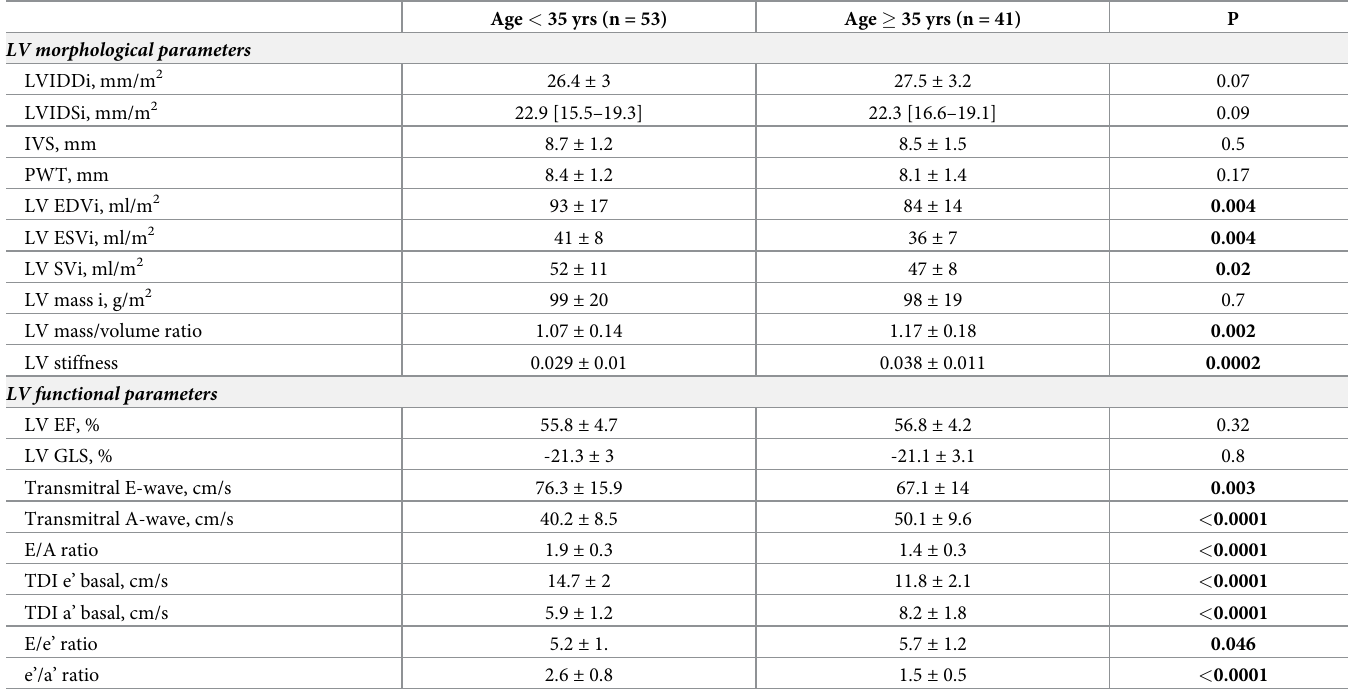
Table 2. Left ventricular morphology and function.